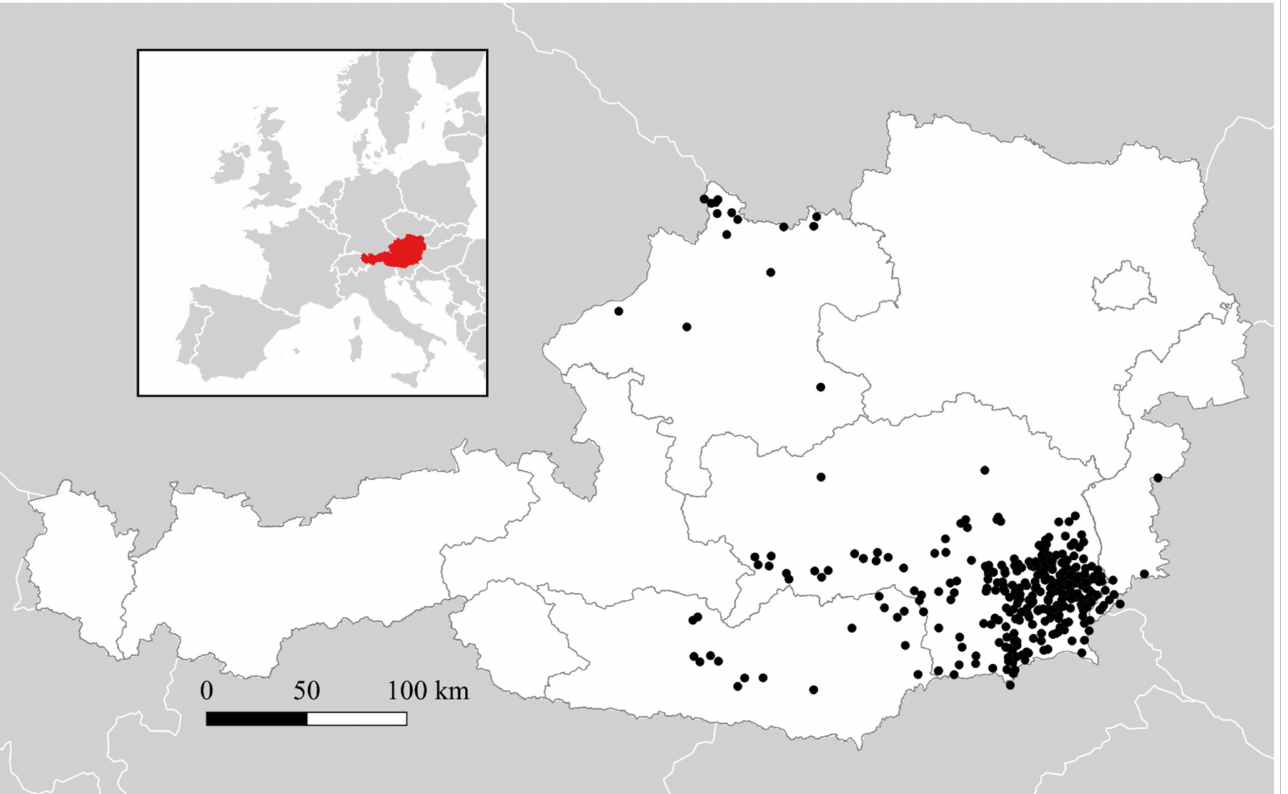
Figure 1. Map of Puumala orthohantavirus infections in human patients in Austria, 2009–2019. The inset map shows Austria (red) within Europe. Black dots show the location of 506 georeferenced, confirmed patient infections out of approximately 900 officially reported cases. Austrian Federal States are outlined in the larger map, with a large concentration of cases in South-eastern Styria and a smaller cluster in northern Upper